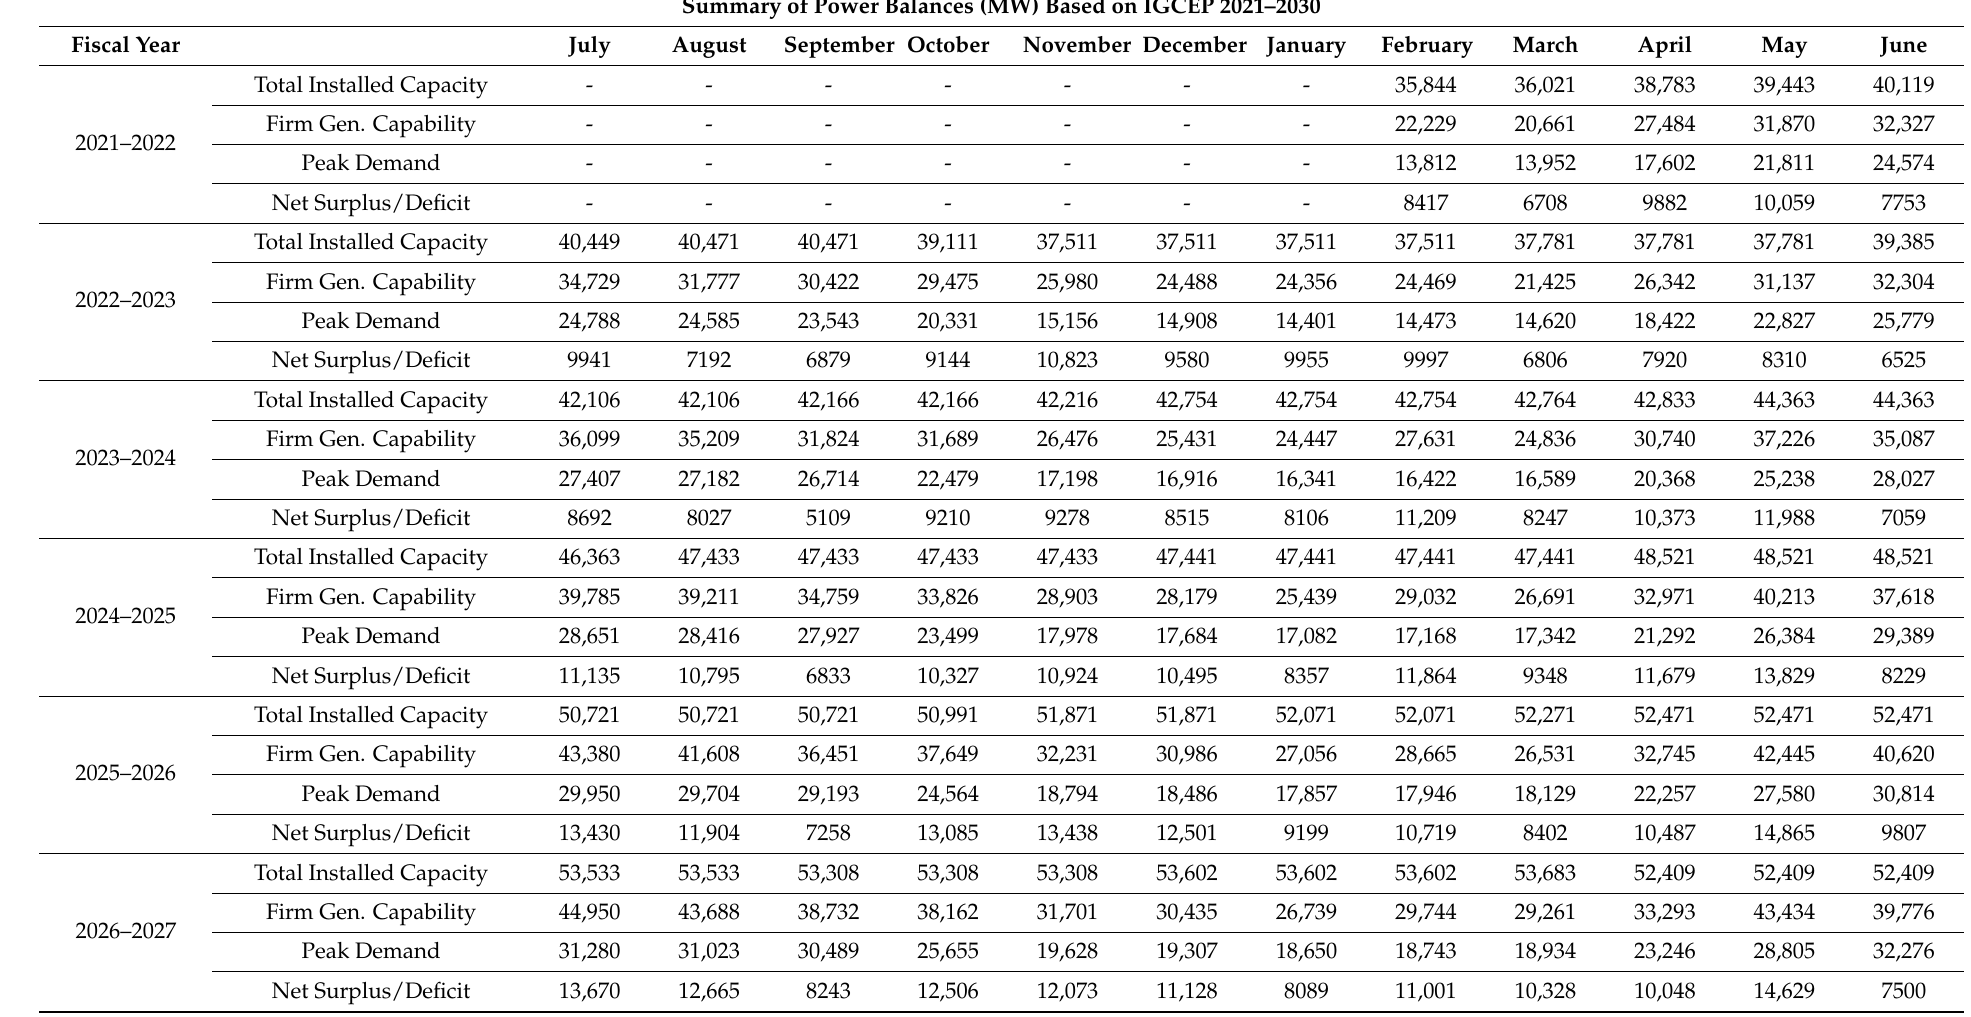
Table 2. NTDC plant capacity